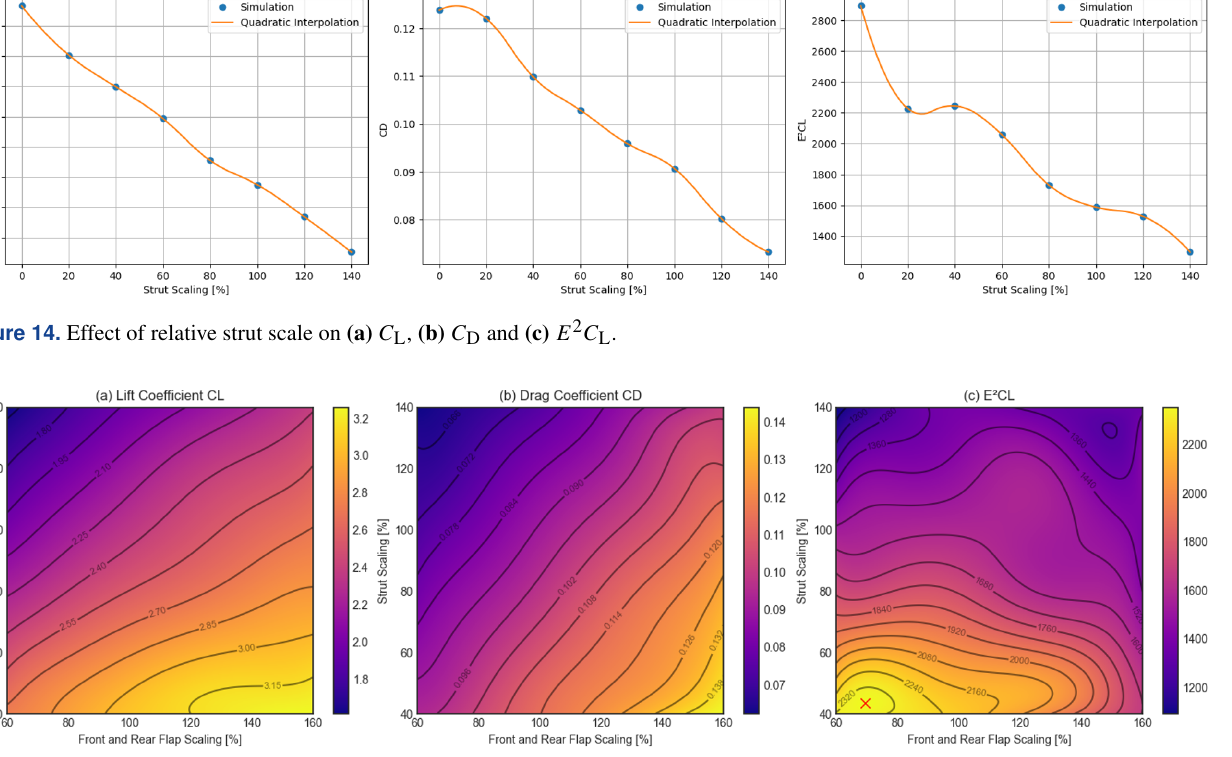
Figure 15. Effect of relative strut and flap scale altered together on (a) C L , (b) C D and (c) E 2 C L